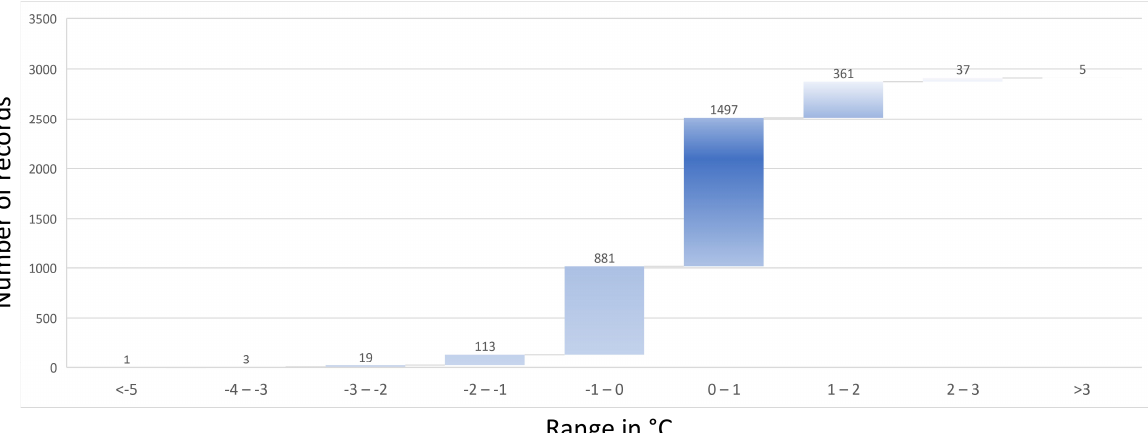
Figure 17. Prediction deviation vs. number of